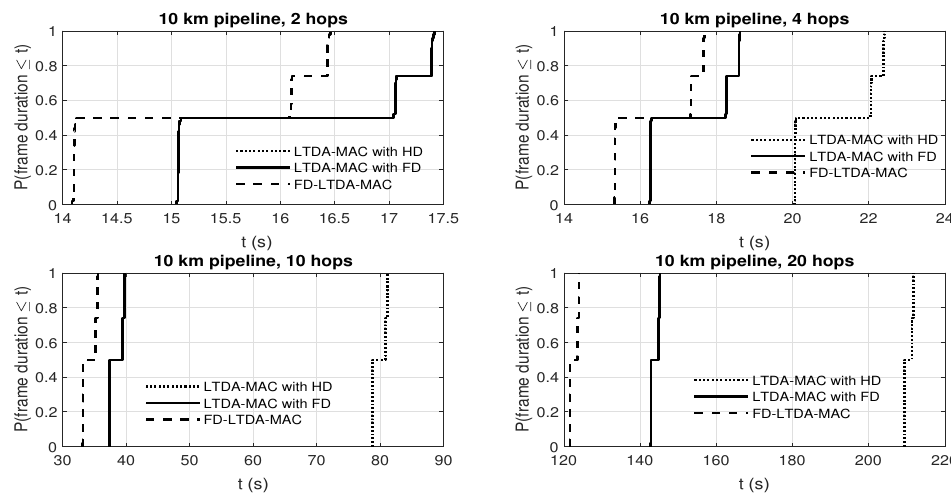
Figure 10. Frame duration cdfs of LTDA-MAC with HD nodes, LTDA-MAC with FD nodes, and FD-LTDA-MAC for a 10 km pipeline.